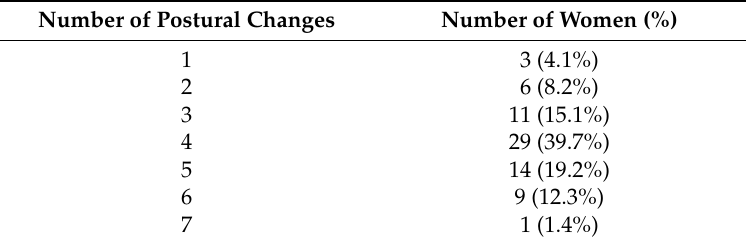
Table 1. Number of postural changes undergone by the parturients in the experimental group ( n = 73).